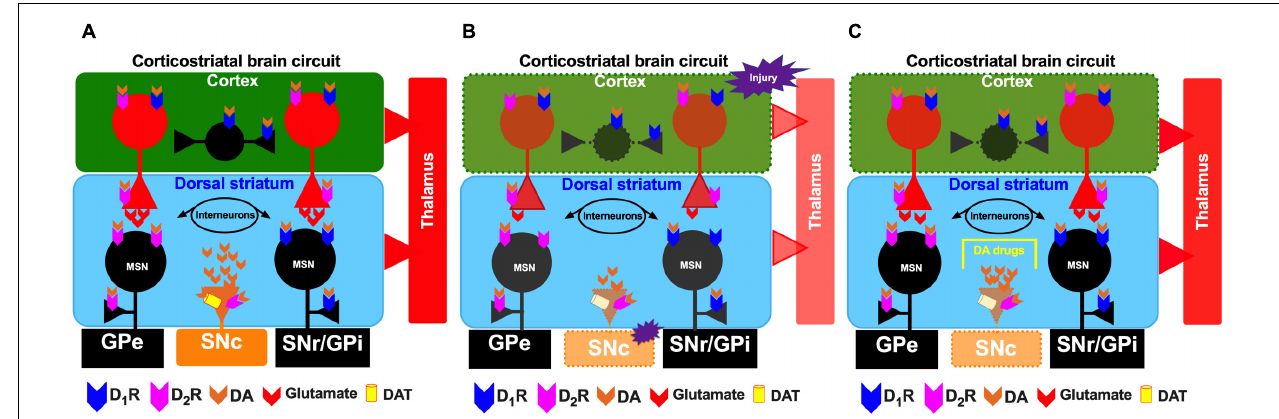
FIGURE 1 | Schematic representation of the corticostriatal pathway under normal conditions (A) , under conditions of cortical injury (B) , and during the injury recovery process/the proposed effects of administration of dopaminergic drugs (C) . For the circles, triangles and lines, red indicates excitatory projections, whereas black indicates inhibitory projections. The color orange represents the substantia nigra pars compacta (SNc). The dotted lines indicate depletion by injury in the cerebral cortex and SNc. SNr, substantia nigra pars reticulata; GPi, internal segment of the globus pallidus; GPe, external segment of the globus pallidus; STN, subthalamic